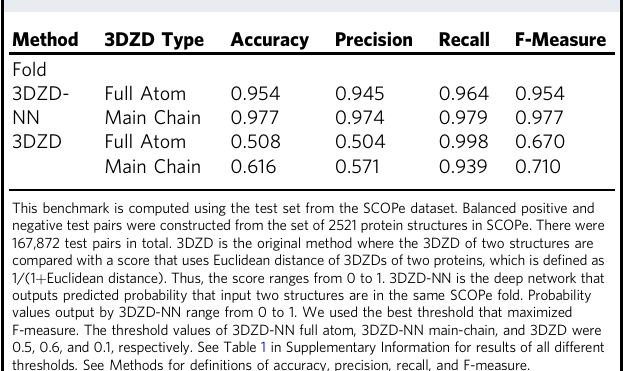
Fig. 4c, d shows examples of false positives, i.e. two pairs of structures of different folds where both 3DZD-NN and 3DZD recognized them as the same fold. The structures in Fig. 4c have similar spatial arrangements of secondary structures, each with a